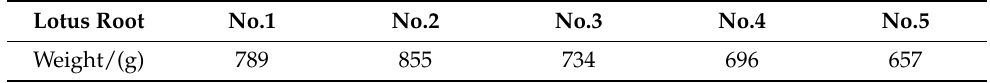
Table 1. Weights of the testing lotus roots.